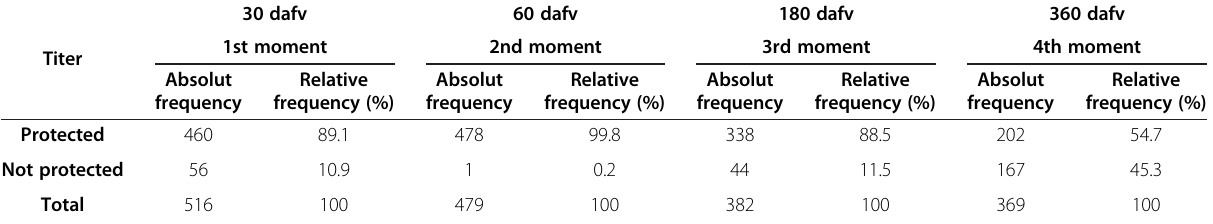
Table 1 Percentage of dogs with protective antibody titers against rabies vaccinated with Fuenzalida-Palácios modified vaccine at four different periods, 2014